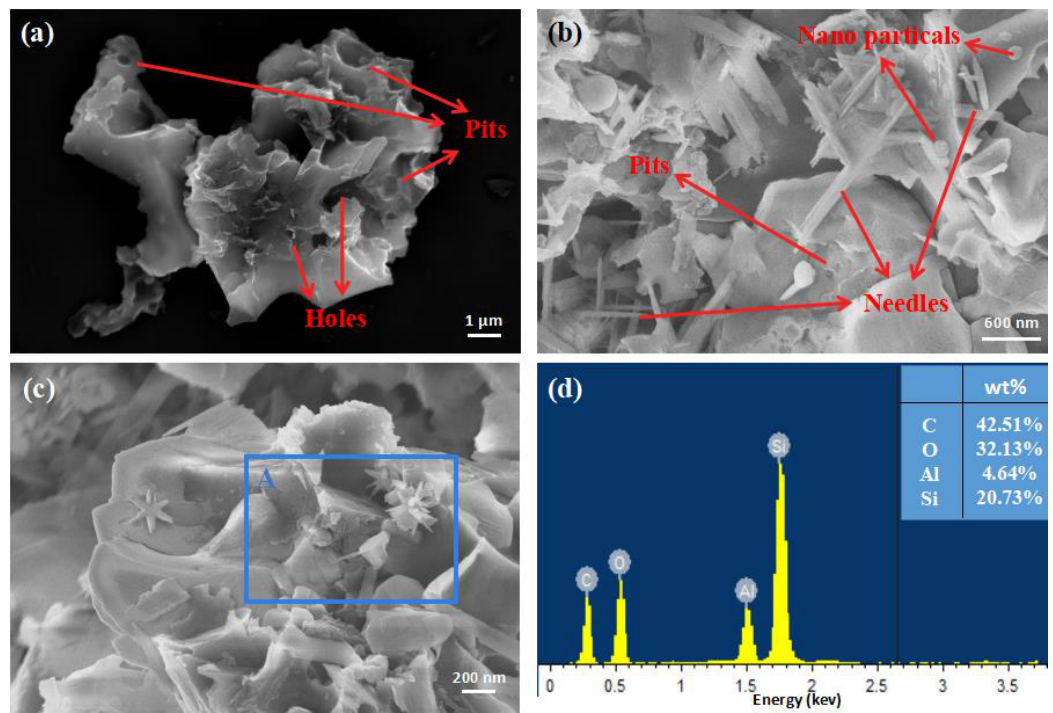
Figure 4. ( a – c ) SEM images of ore sample and ( d ) EDS elemental spectrum of area A.